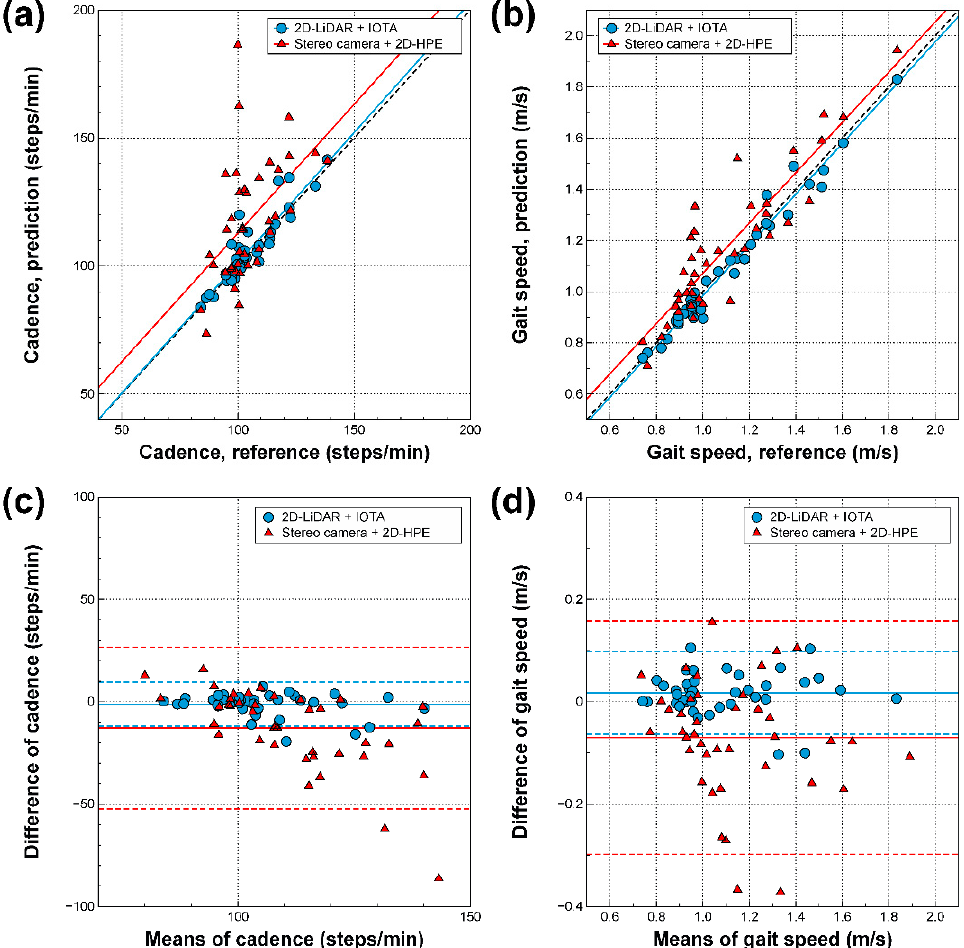
Figure 5. Cadence and gait speed derived from spatiotemporal locations of tracked ankles via 2D- LiDAR with IOTA and stereo camera with 2D-HPE. ( a , b ) Regression and ( c , d ) Bland–Altman plots with motion capture system for 2D-LiDAR with IOTA and stereo camera with 2D-HPE for cadence ( a , c ) and gait speed ( b , d ). The black dotted lines in the regression plots are ideal lines for perfect correlations. In the Bland–Altman plots, each solid horizontal line represents the bias of each modality. The upper and lower dashed horizontal lines from each bias represent 95% confidence intervals.